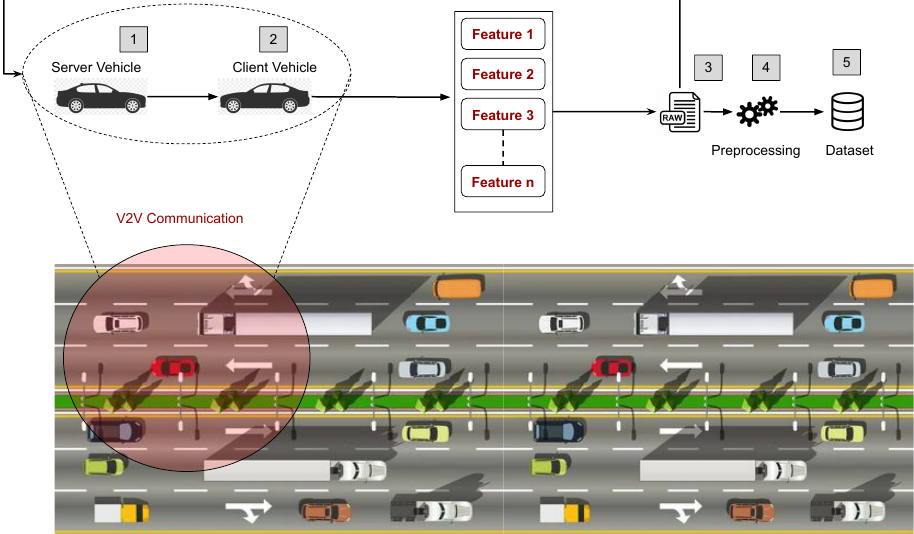
Figure 4. Proposed scheme for the data collection